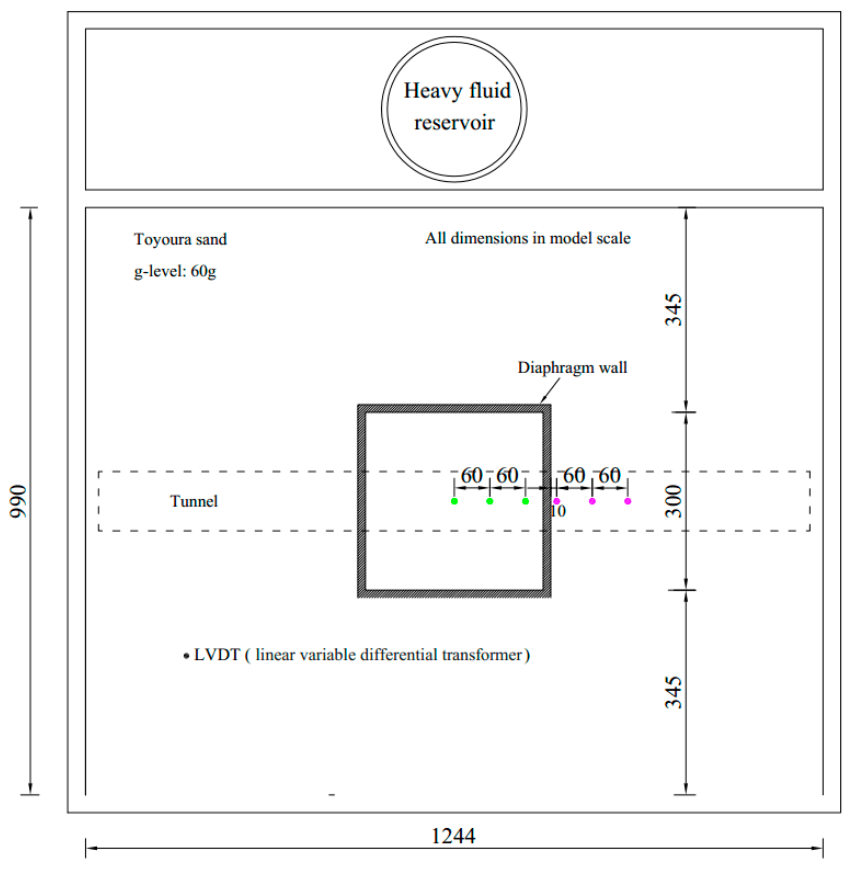
Figure 1. Plan view of the centrifuge model (redraw from Ng et al., 2013) [4].